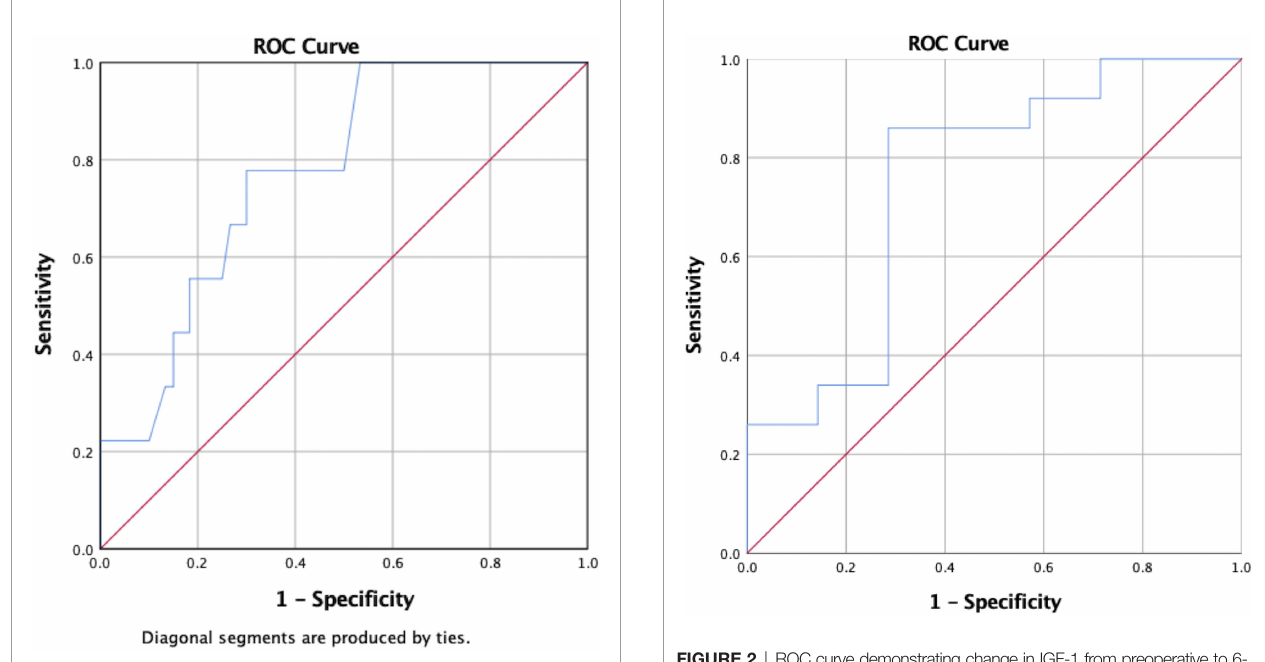
FIGURE 1 | ROC curve demonstrating predictive ability of POD1 GH to predict non-remission.